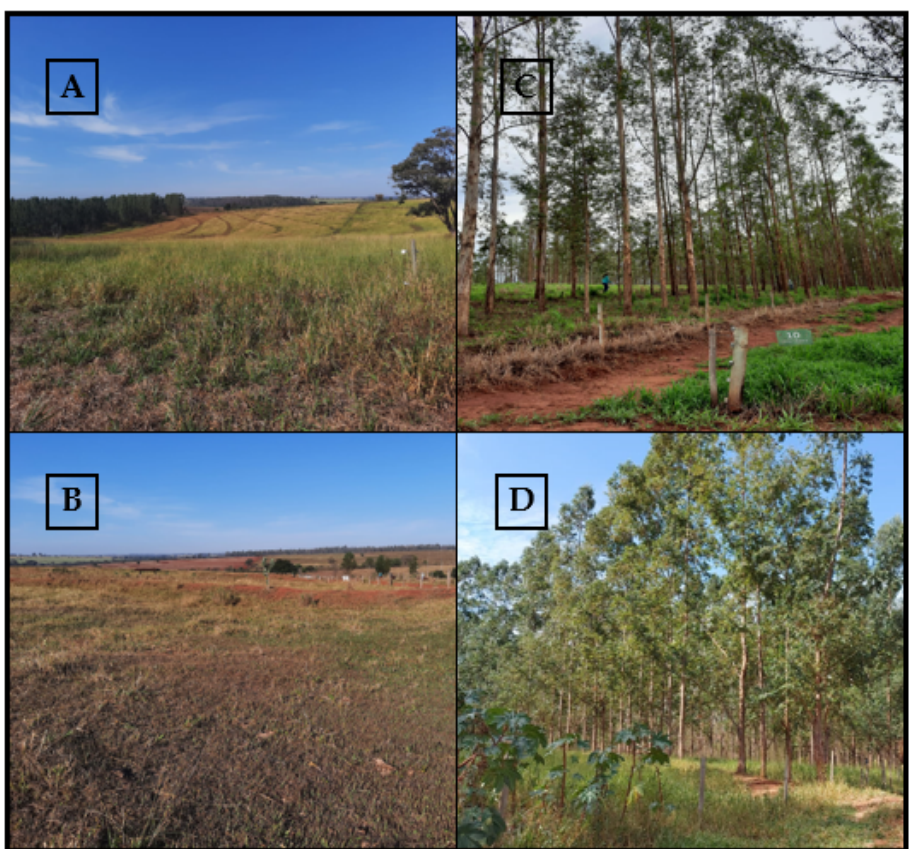
Figure 2. Conditions of research: Integrated Crop–livestock ( A ), bare soil ( B ), integrated crop–livestock with Eucalyptus within triplicate rows, ( C ) and integrated crop–livestock with Eucalyptus within single lines (D ).